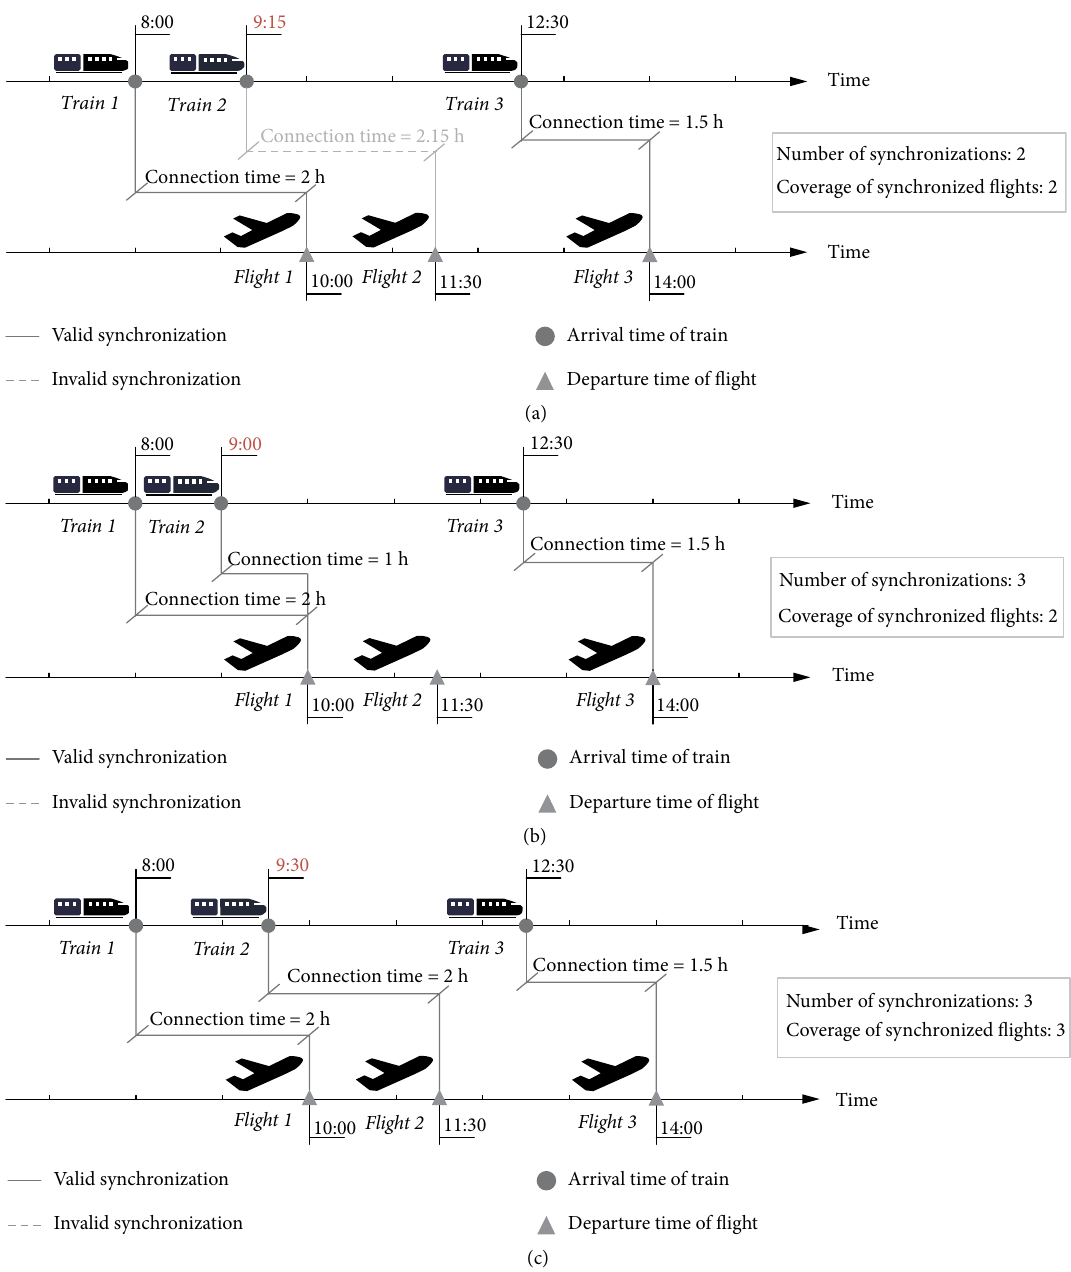
Figure 1: Number of synchronizations and coverage of synchronized